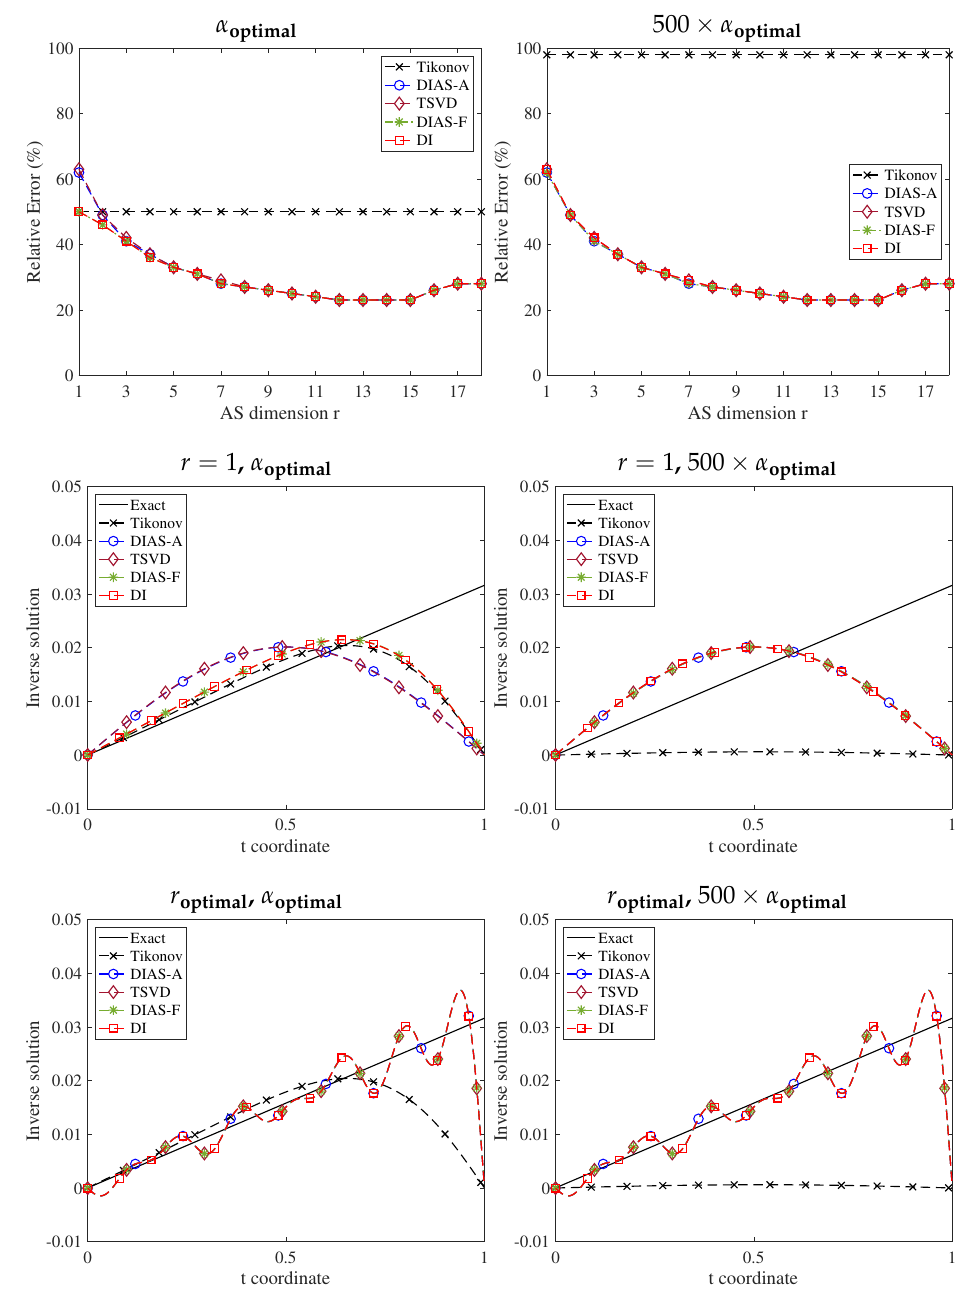
Figure 6. Deriv2, α optimal = 6.6 × 10 − 4 . Comparison of different DIAS regularizations and Tikhonov regularization. Top row: relative errors in the inverse solutions for different regularization methods for two values of regularization parameter. Middle row: inverse solutions with DIAS regularizations with one-dimensional active subspace and Tikhonov regularization for two values of regularization parameter. Bottom row: inverse solutions with DIAS regularizations with the optimal dimension ac- tive subspace ( r optimal = 15) and Tikhonov regularization for two values of regularization